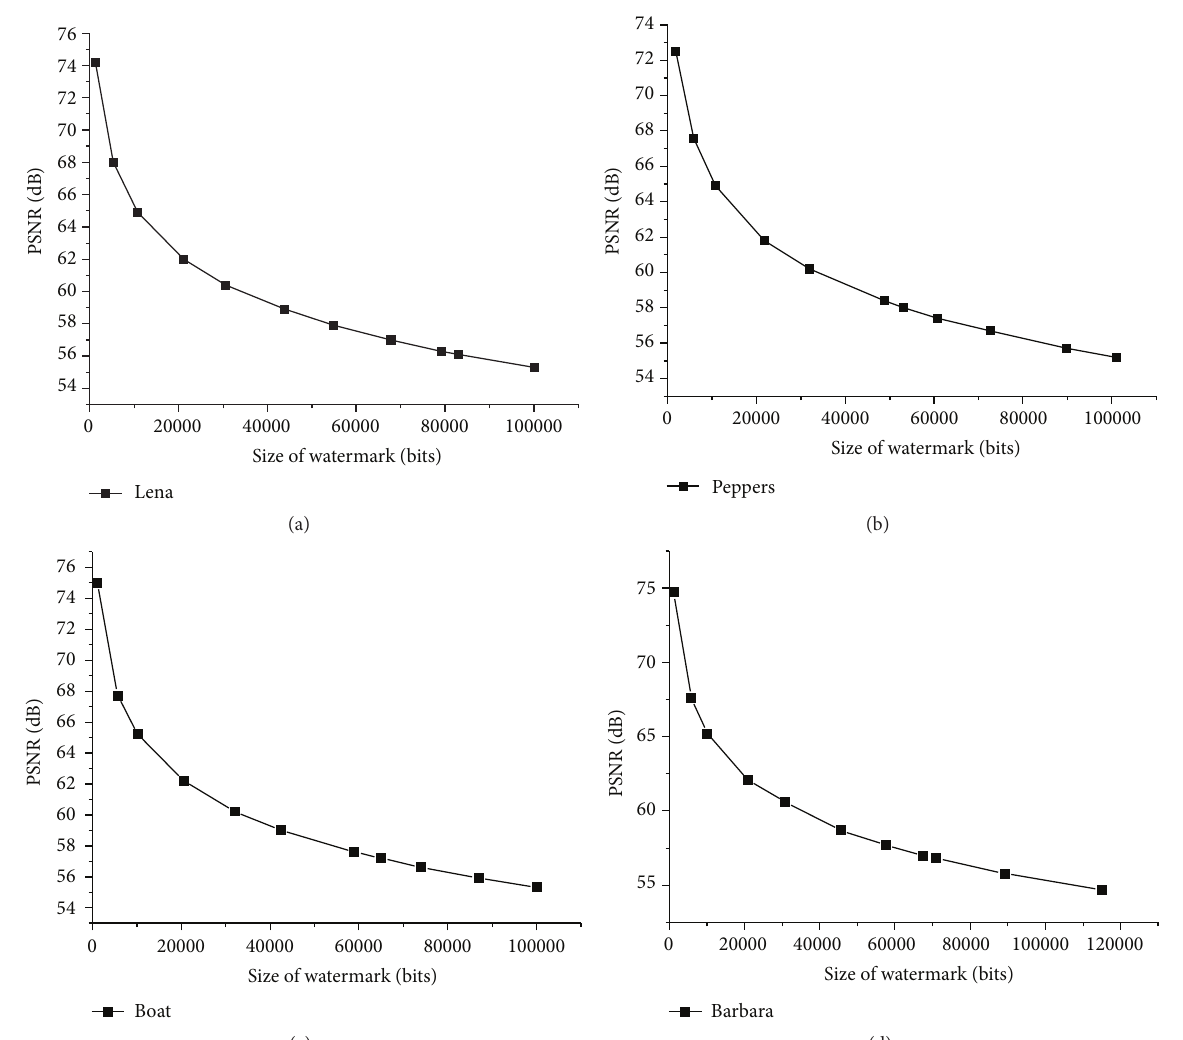
Figure 3: Performance in terms of watermark size versus PSNR: (a) Lena, (b) peppers, (c) boat, and (d) Barbara.